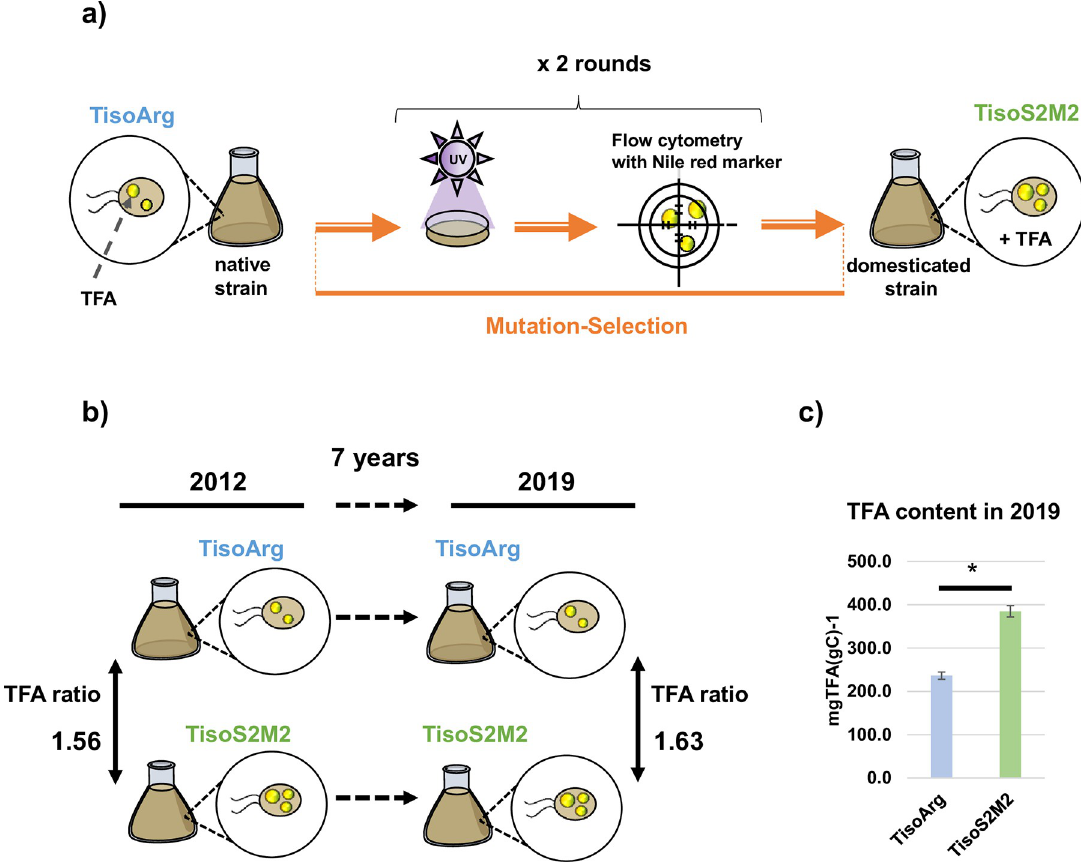
Fig 1. Strategy of the improvement program and comparison of the total fatty acid (TFA) content between the domesticated strain TisoS2M2 strain and the native strain TisoArg. a) Illustration of the strategy of the improvement program used in 2012 [10] to obtain TisoS2M2. b) Comparison of TFA ratio obtained in 2012 [10] and 2019 (this study) for TisoArg and TisoS2M2. c) Comparison of the TFA content of TisoArg and TisoS2M2 measured in 2019. Bars represent the means of two biological replicates ± SD. * , p < 0.05 by t-